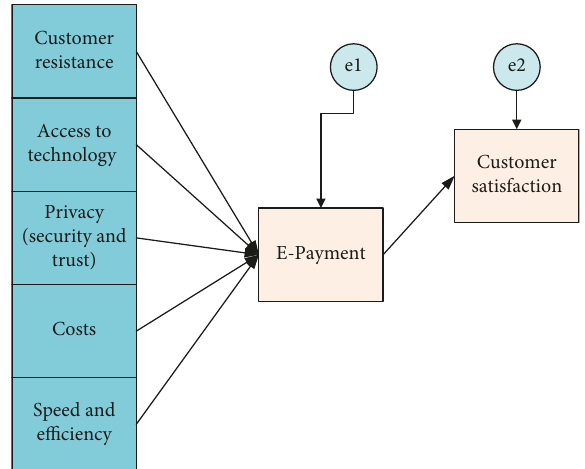
Figure 1: Research structural model. H01: There is no effect of the EP system on CS under COVID-19 at the level of